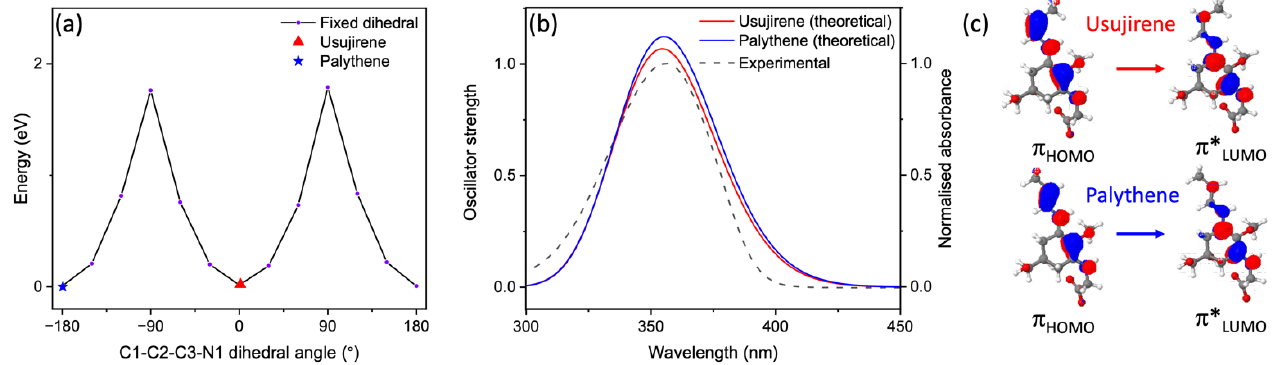
Figure 2. ( a ) Electronic ground state potential energy surface of usujirene to palythene by rotation around the C1-C2-C3-N1 bond computed at the DFT/PBE0/6-311++G** level of theory in implicitly modelled water. ( b ) Predicted UV-visible spectra for usujirene and palythene (solid lines), computed at the RI-CC2/def2-TZVP level of theory in implicitly modelled water, overlaying the experimental UV-visible spectrum (dashed line). ( c ) The orbitals corresponding to the S 1 ← S 0 transition for usujirene and palythene.